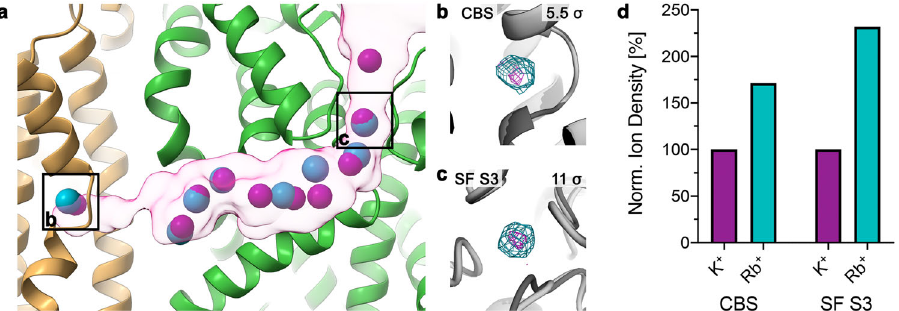
Fig. 3 Ions traverse the intersubunit tunnel. a Potential ions in K + - and Rb + -loaded E1·ATP KdpFABC within the intersubunit tunnel, from the KdpA SF (right) to the KdpB CBS (left). Based on the high ion concentrations in each sample, densities were assigned as K + and Rb + ions, respectively. K + visualized in purple, Rb + in turquoise. b , c Comparison of densities in the CBS and in SF position S3, respectively, between the K + - and Rb + -loaded maps when low-pass fi ltered to 3.2 Å and displayed at the same contour level ( σ ). Densities in the Rb + -loaded structure (turquoise) are stronger than in the K + -loaded structure (purple), suggesting that they correspond to ions and that Rb + is integrated into the complex. Contour levels are indicated in the top right corner of each panel. d Quanti fi cation of the effect of Rb + substitution in the CBS and SF S3. Densities were low-pass fi ltered to 3.2 Å, normalized to the K + -loaded structure for each position, and indicate a ca . two-fold signal increase in the Rb + -loaded structure in both positions. For the full, non- normalized comparison of all ion densities, see Supplementary Fig.